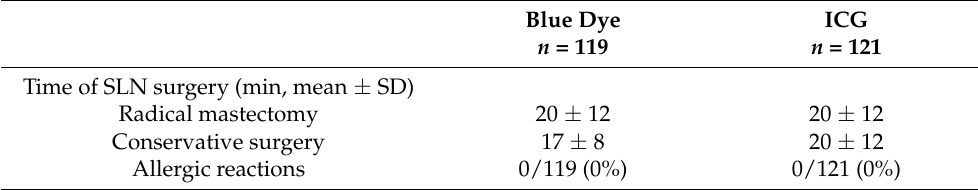
Table 4. Duration of SLNB and allergic